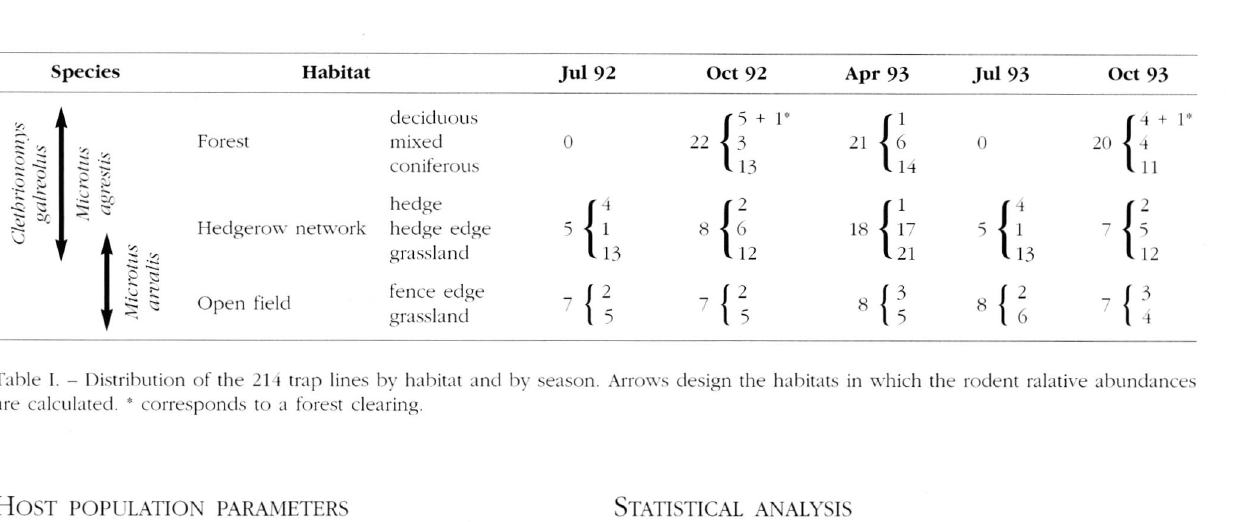
HOST POPULATION